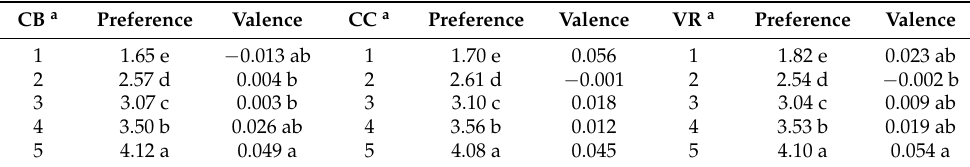
Table 3. Effects of ‘visual attractiveness’ factor on aesthetic preference and emotional